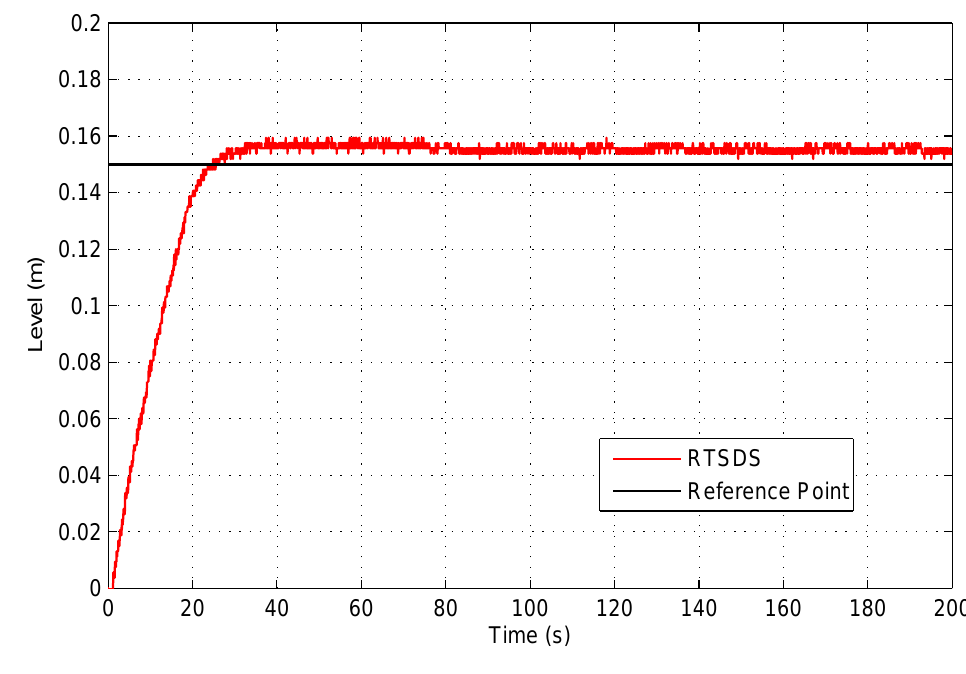
Figure 19. Results obtained for the RTSDS platform utilizing an external PID controller